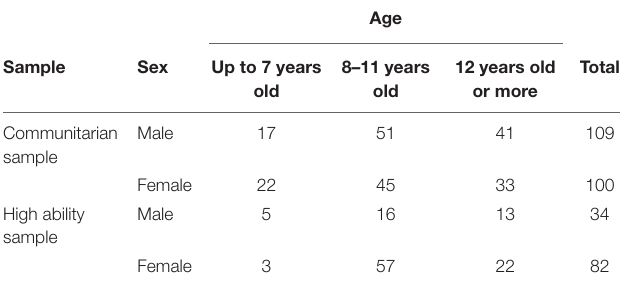
TABLE 2 | Descriptive variables of age and sex in the two